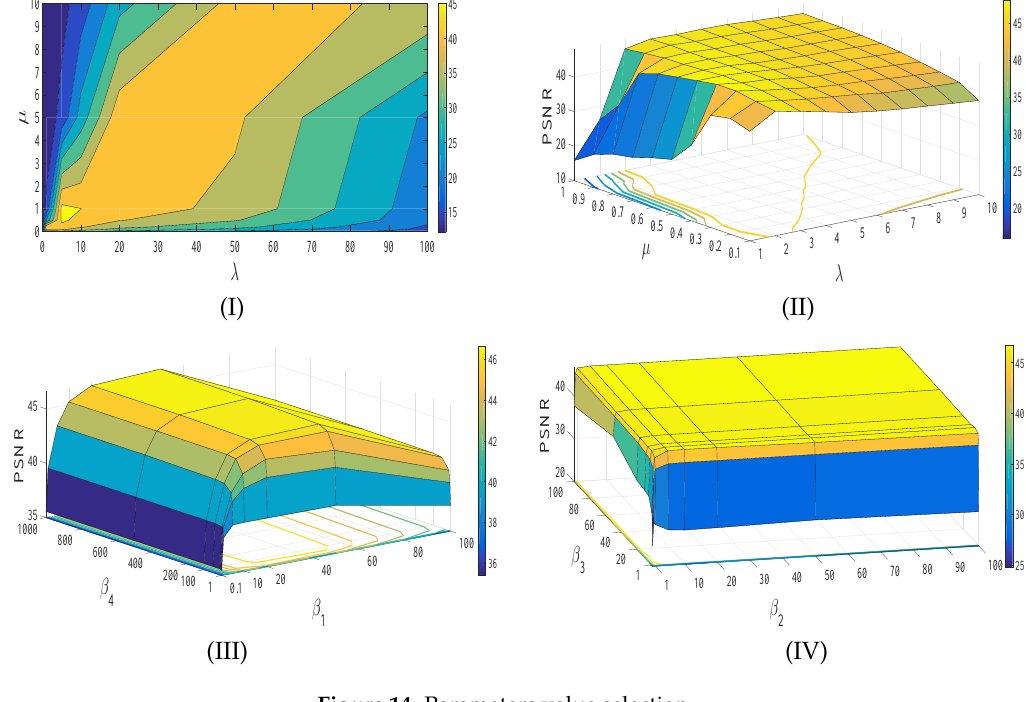
Figure 14. Parameters value selection